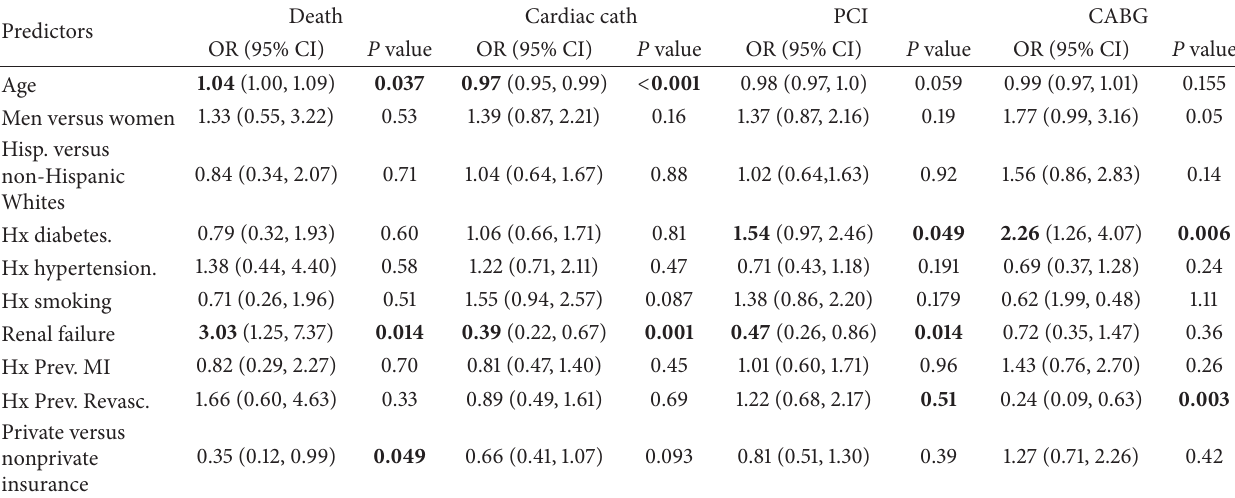
Table 3: Odds ratio for selected outcomes in Hispanic and non-Hispanic white patients with a confirmed